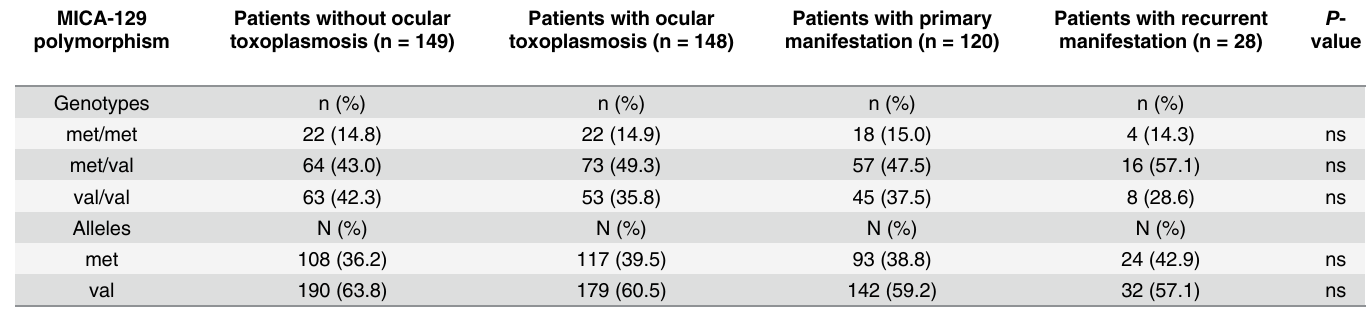
with primary or recurrent ocular manifestations of the disease. The MICA-129 val allele and the heterozygous MICA-129 met/val genotypes were the most common in all groups (Table 3). Frequency of MICA~HLA-B and MICA~HLA-C haplotypes in patients with and without ocular manifestations of toxoplasmosis The most common MICA~HLA haplotypes are shown in Table 4. The MICA (cid:3) 002~HLA-B (cid:3) 35 haplotype was associated with increased risk of developing ocular toxoplasmosis ( P -value = 0.04; OR: 2.20; 95% CI: 1.08 – 4.93), while the MICA (cid:3) 008~HLA-C (cid:3) 07 haplotype was associated with Table 3. Genotype and allele frequencies of the MICA-129 polymorphism (rs1051792) in patients with and without ocular toxoplasmosis and its manifestation as primary or recurrent P - MICA-129 Patients without ocular Patients with ocular Patients with primary Patients with recurrent polymorphism toxoplasmosis (n = 149) toxoplasmosis (n = 148) manifestation (n = 120) manifestation (n = 28) value Genotypes met/val ns